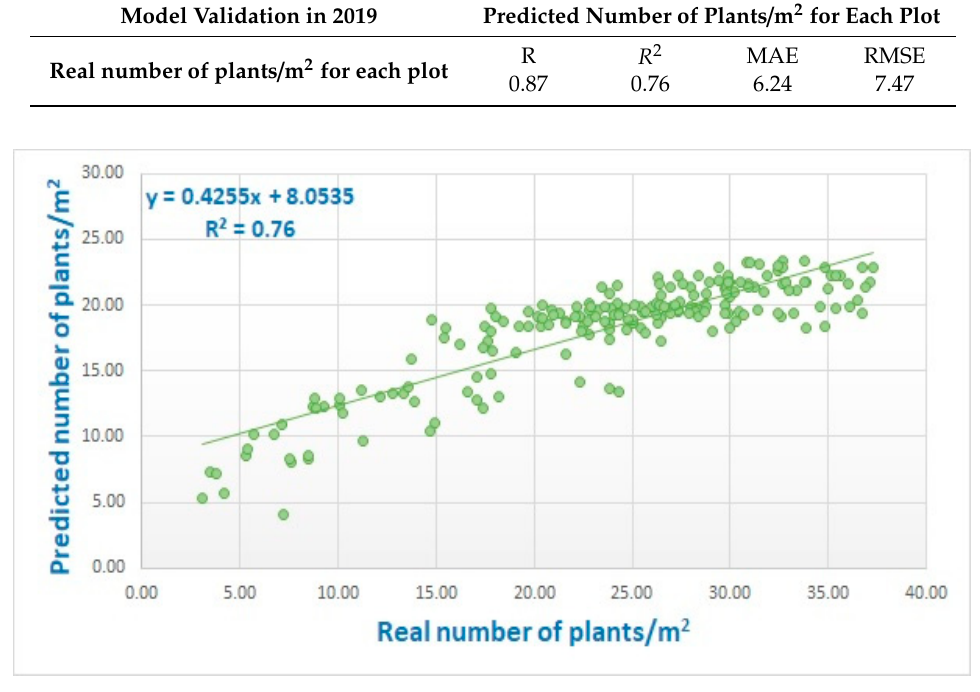
Figure 3. Correlation between the real and predicted number of plants/m 2 for each of the 200 experimental plots for model validation in 2019. R 2 —value of coefficient of determination.